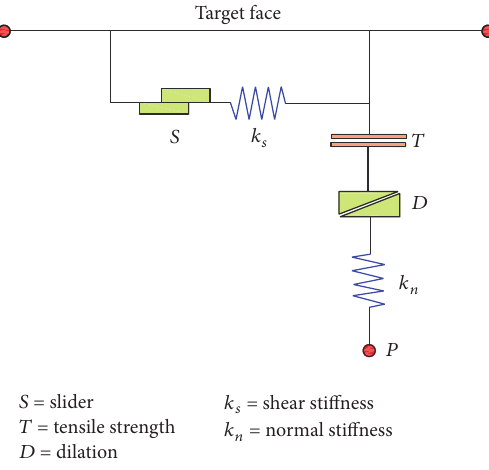
Figure 4: Components of the interface constitutive